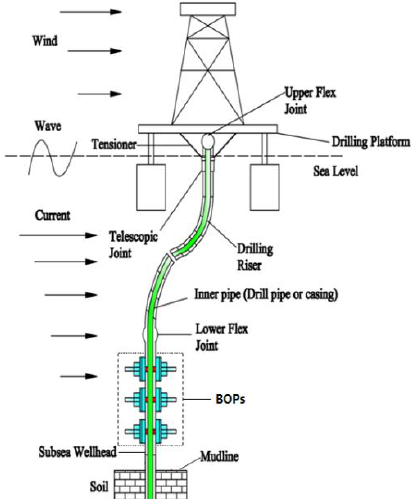
Figure 1. Schematic diagram for typical drilling riser system.